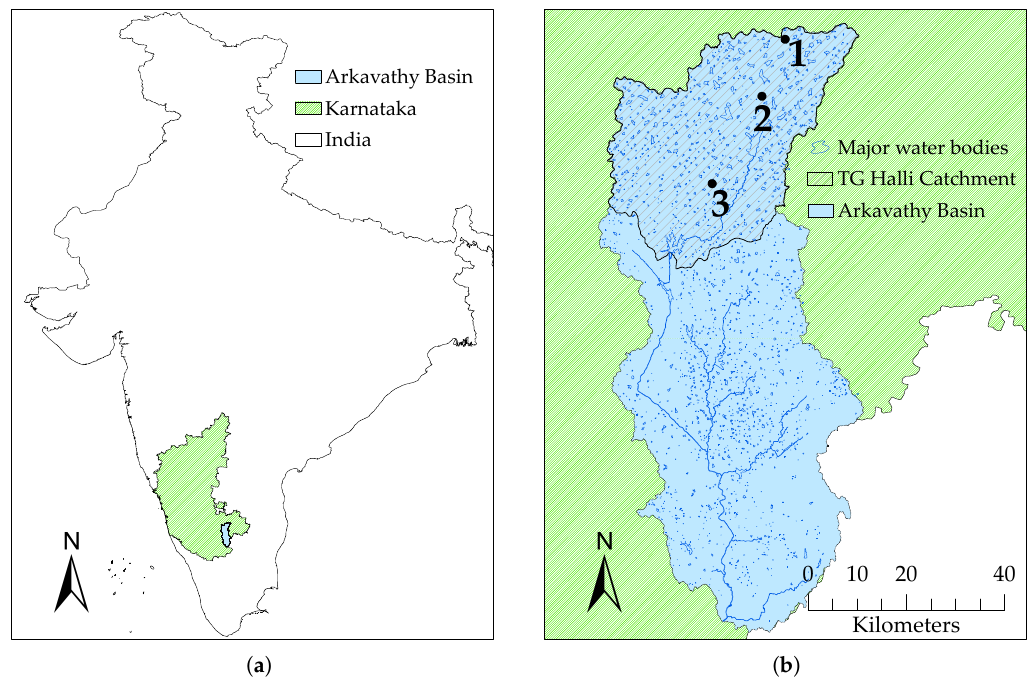
Figure 1. This figure illustrates the geographic context of the study sites in this paper. ( a ) contains the location of the Arkavathy Basin in Karnataka, India, and ( b ) shows the location of TG Halli reservoir within the Arkavathy Basin, where the three study sites are located: (1) Hadonahalli tank (farthest upstream), (2) SM Gollahalli tank and (3) Nelamangala lake (farthest downstream). The direction of flow in this watershed is from North to